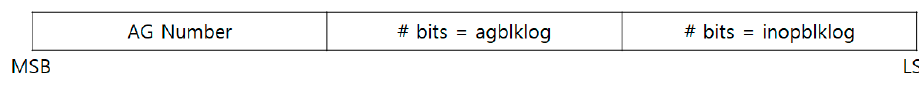
Figure 6. Inode number structure of XFS file system.